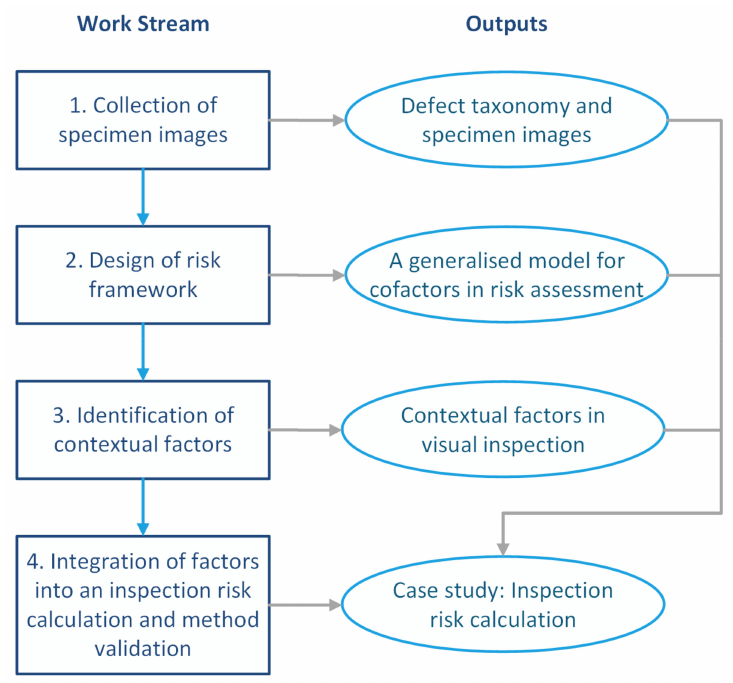
Figure 3. Research approach and